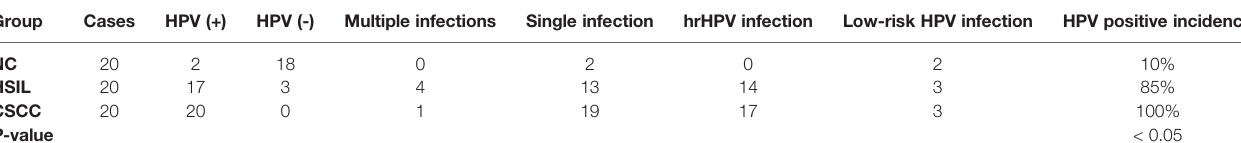
TABLE 1 | HPV infection in 60 cases of cervical lesions.